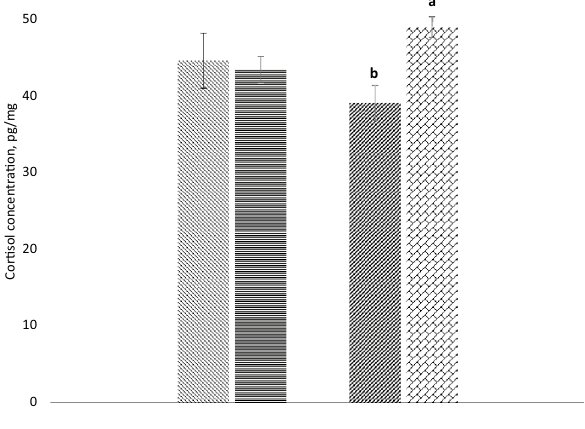
Figure 2. Effects of total dietary fiber (TDF) levels and soluble, insoluble dietary fiber ratio on hair cortisol concentration of sows. Superscript a, b means with different superscripts indicate statistical significance (P < 0.05).